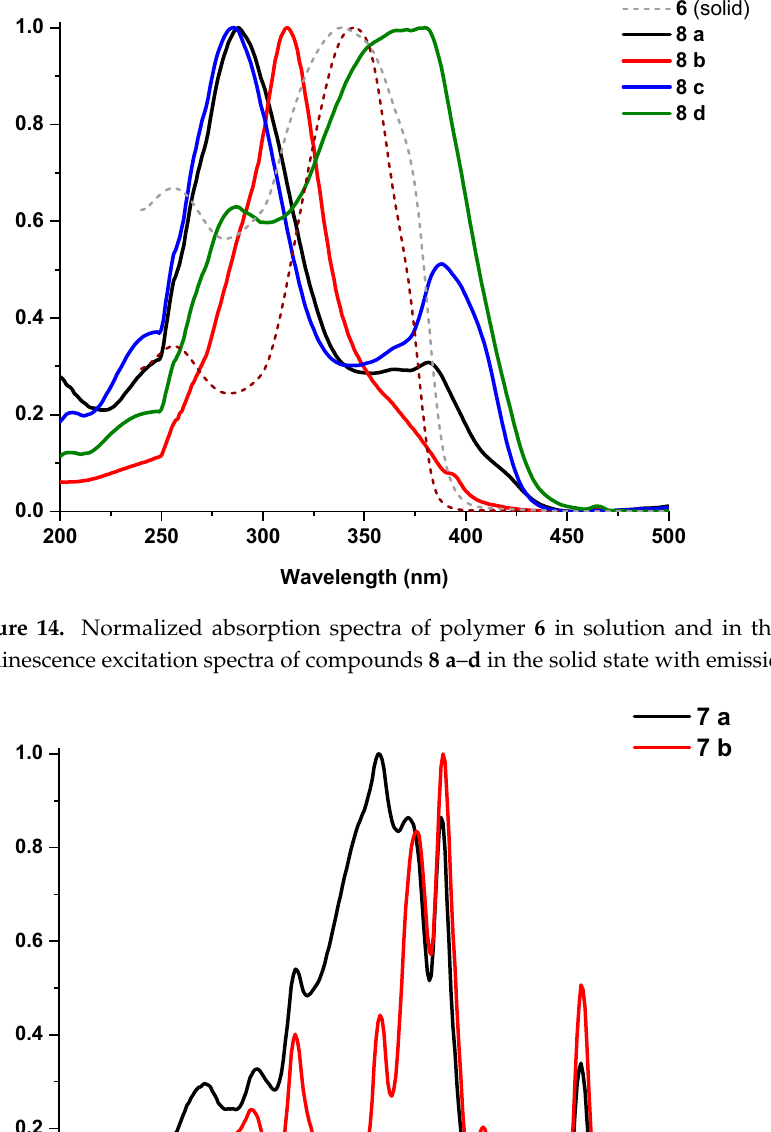
Figure 15. Normalized luminescence excitation spectra of compounds 7 a , b in the solid state with